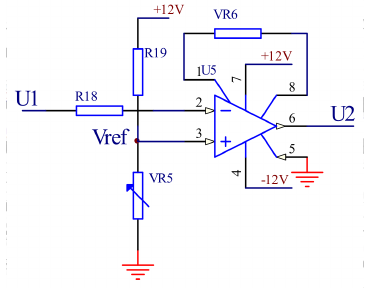
Figure 7. The feedback control circuit.